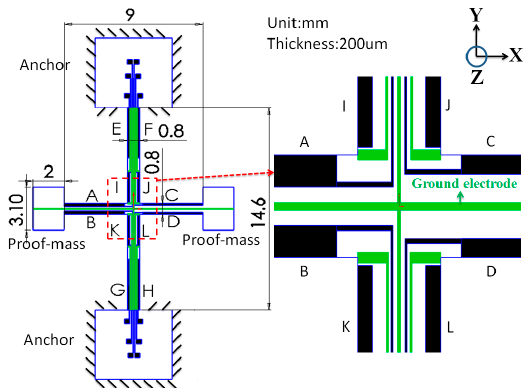
Figure 2. Conceptual design of the proposed gyroscope. The drive electrodes and sense electrodes are drawn in black. The ground electrodes are drawn in green.